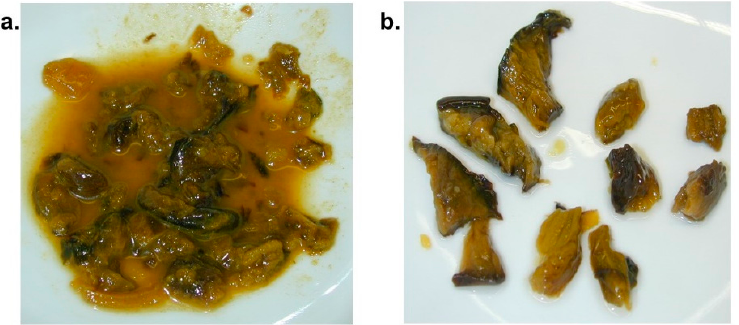
Figure 3. Mushroom residues from stomach contents of case 1 ( a ) before and ( b ) after preparation for analysis.